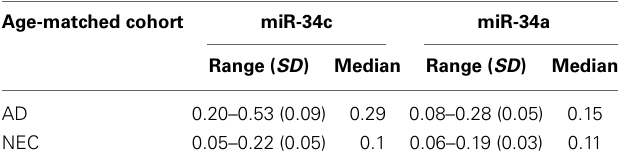
Table 3 | Ranges of 1/deltaCt levels of plasma microRNAs in Alzheimer disease (AD) patients and normal elderly controls (NEC), with standard deviation (SD) and median, for miR-34c and miR-34a in age-matched